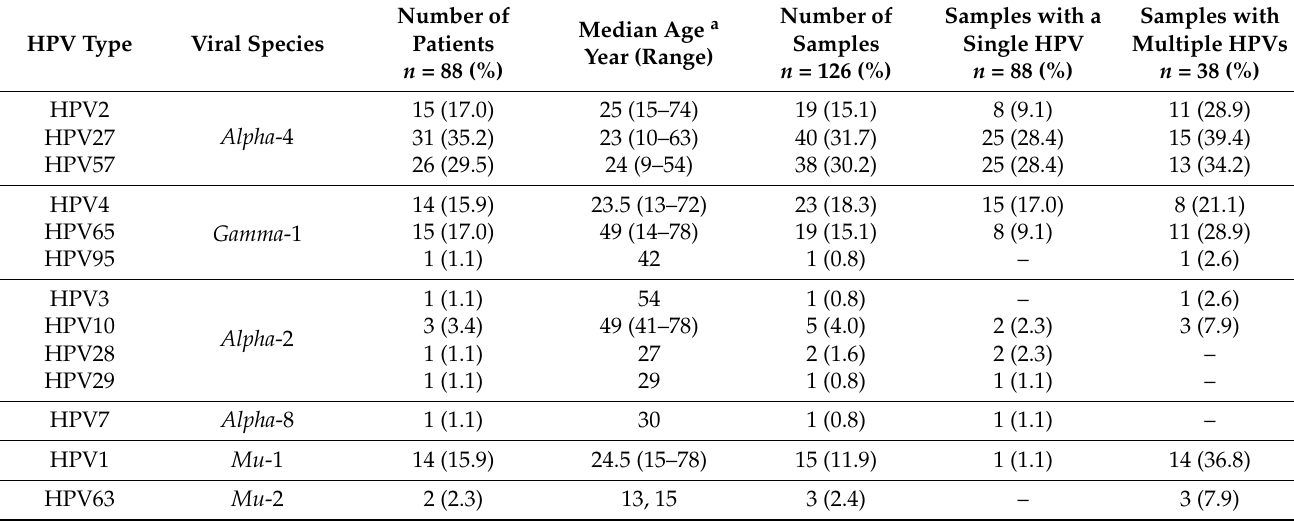
Table 2. Prevalence of human papillomavirus (HPV) types in 126 HPV-positive histologically con- firmed common warts obtained from 88 immunocompetent